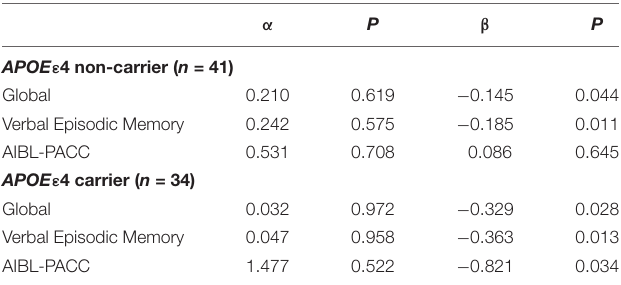
TABLE 3 | Association between em PRS ¯ sAPOE and baseline and longitudinal change in cognition in A β high CN older adults. α P